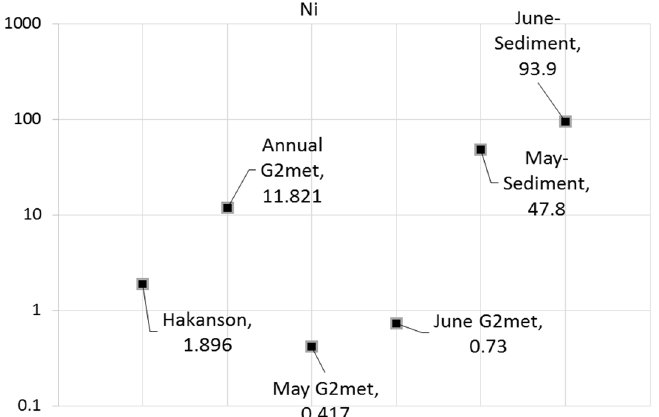
Figure 14. Indicative overview graph of estimated risk values (logarithmic scale) of Ni in the Kouris basin and Ni concentrations in sediments (in mg·kg − 1 ) in Kouris